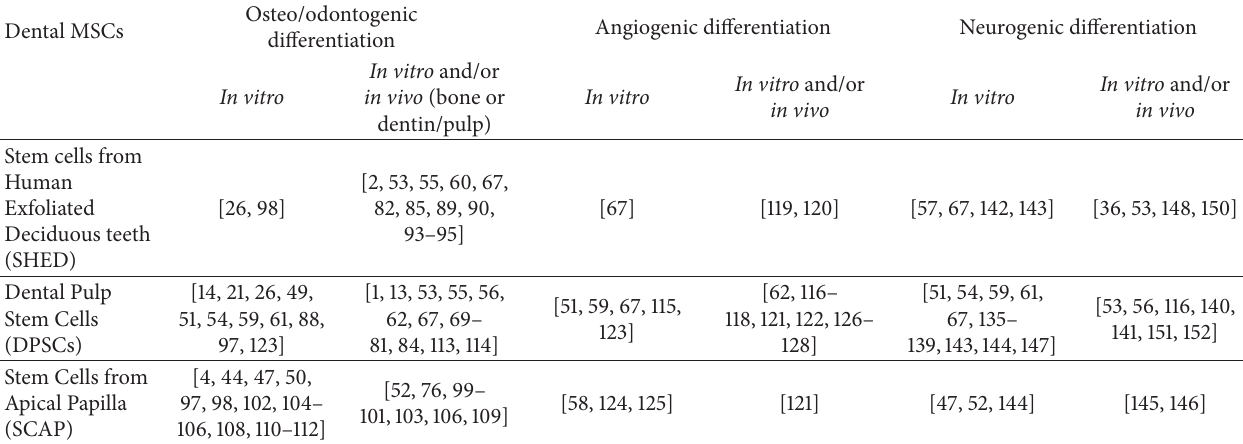
Table 2: Key references on the osteo/odontogenic, angiogenic, and neurogenic differentiation potential of dental MSCs in vitro and in vivo. Dental